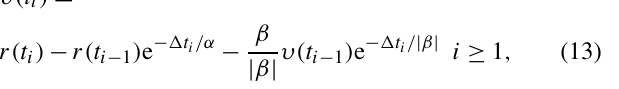
time steps. Note that the time step (cid:49)t in Eq. (13) may be